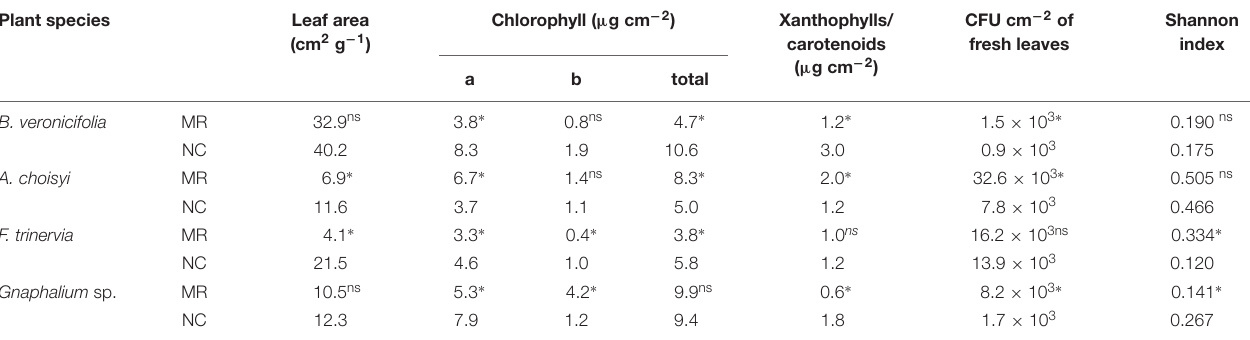
FIGURE 1 | Concentrations of potentially toxic elements on leaf surfaces of four different plant species. Mean ± standard deviation ( n = 5). Leaves samples collected from mine residues (MR) or non-contaminated control site (NC) of four plant species: Brickellia veronicifolia (Bv), Allionia choisyi (Ac), Flaveria trinervia (Ft), and Gnaphalium sp. (G sp.). According to the Mann–Whitney U test, ( ∗ ) means significant and (ns) means non-significant difference ( p < 0.05). A = Zn, B = Cu, C = Cd, D = Pb, E = As, F = Sb. TABLE 1 | Leaf area, chlorophylls concentration, colony-forming units, and diversity index of leaves and isolated epiphytic bacteria. Plant